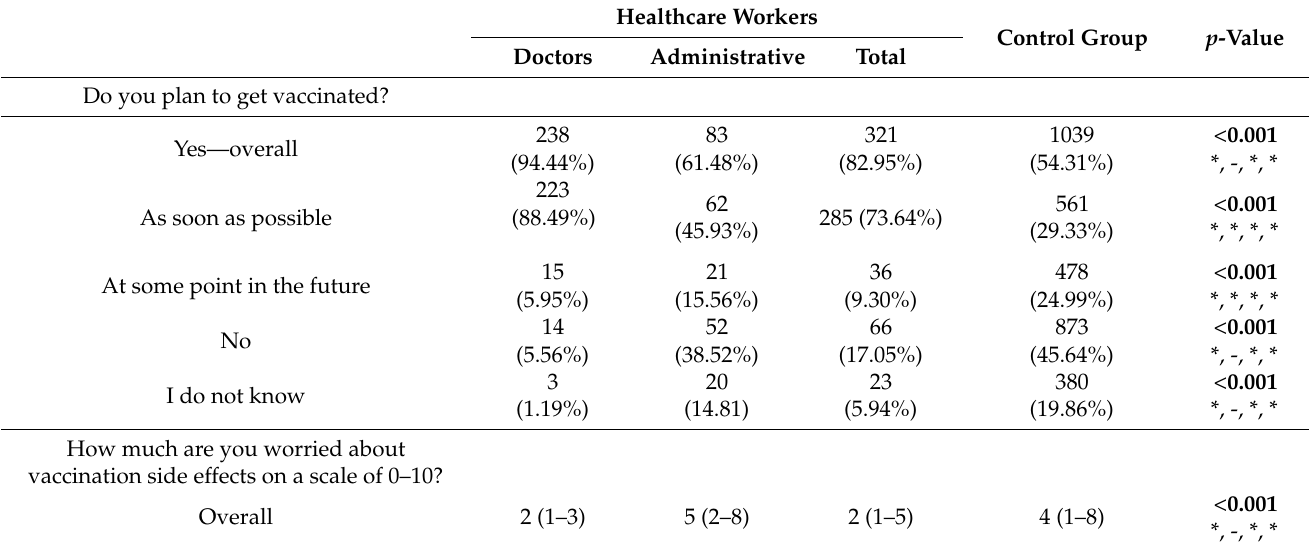
Table 3. Experiences and anxiety related to vaccination among control group and healthcare workers.